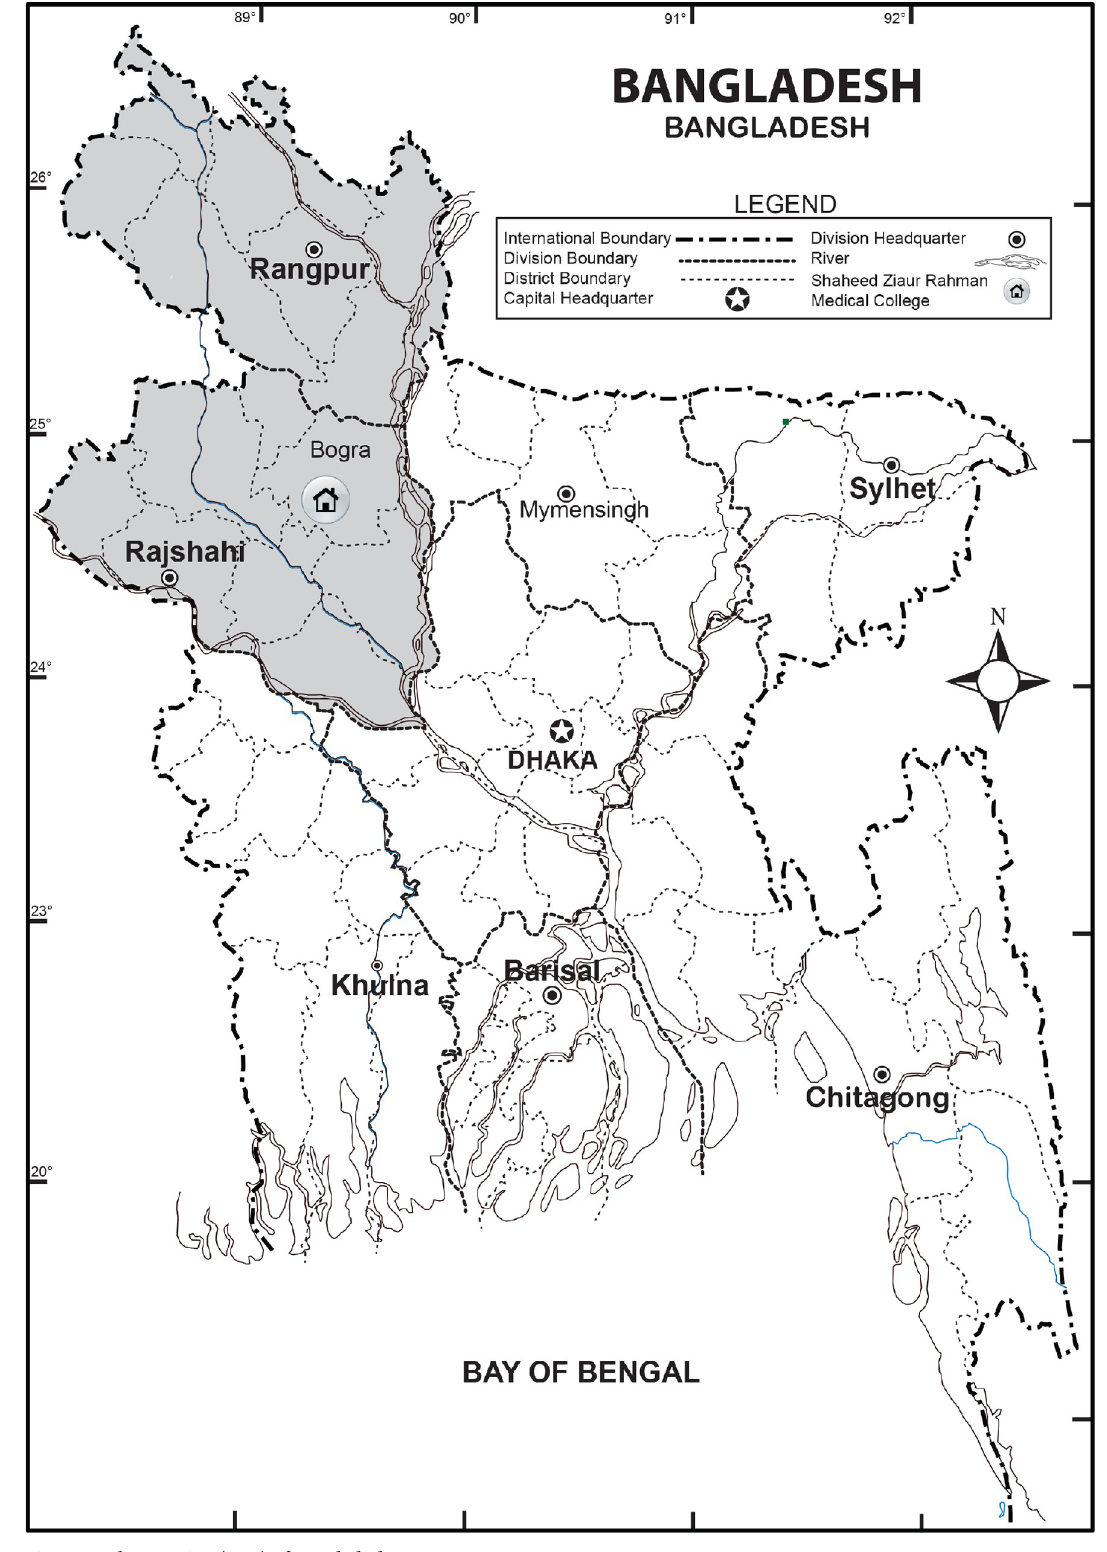
Fig 1. Northern region (grey) of